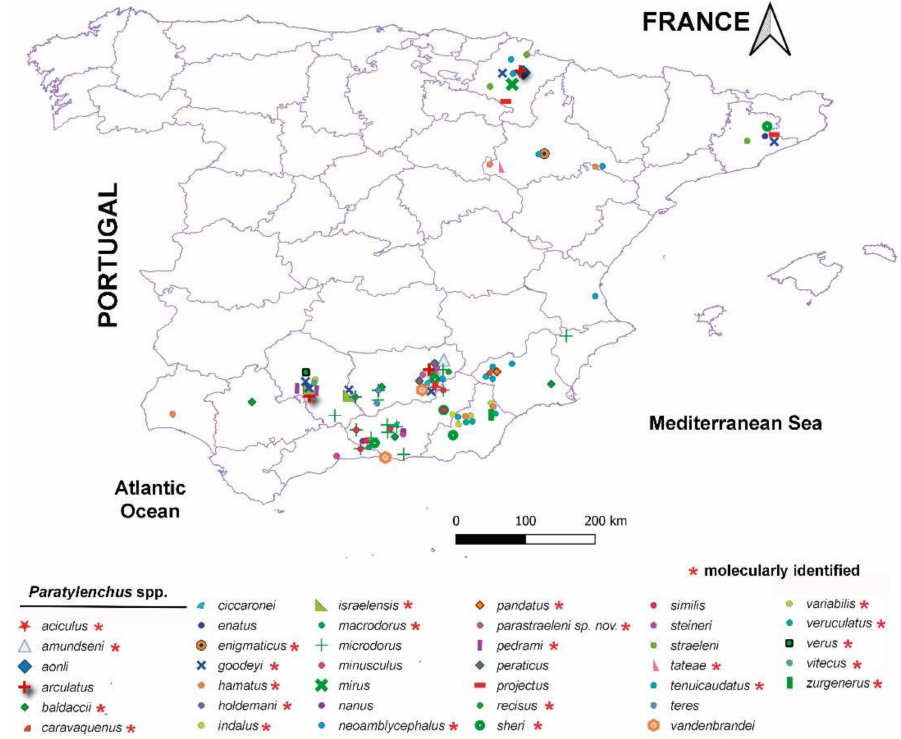
Figure 15. Spain map distribution of Paratylenchus species across all of the country. Species list with asterisk (*) indicated species identified by integrative taxonomy and including molecular analyses